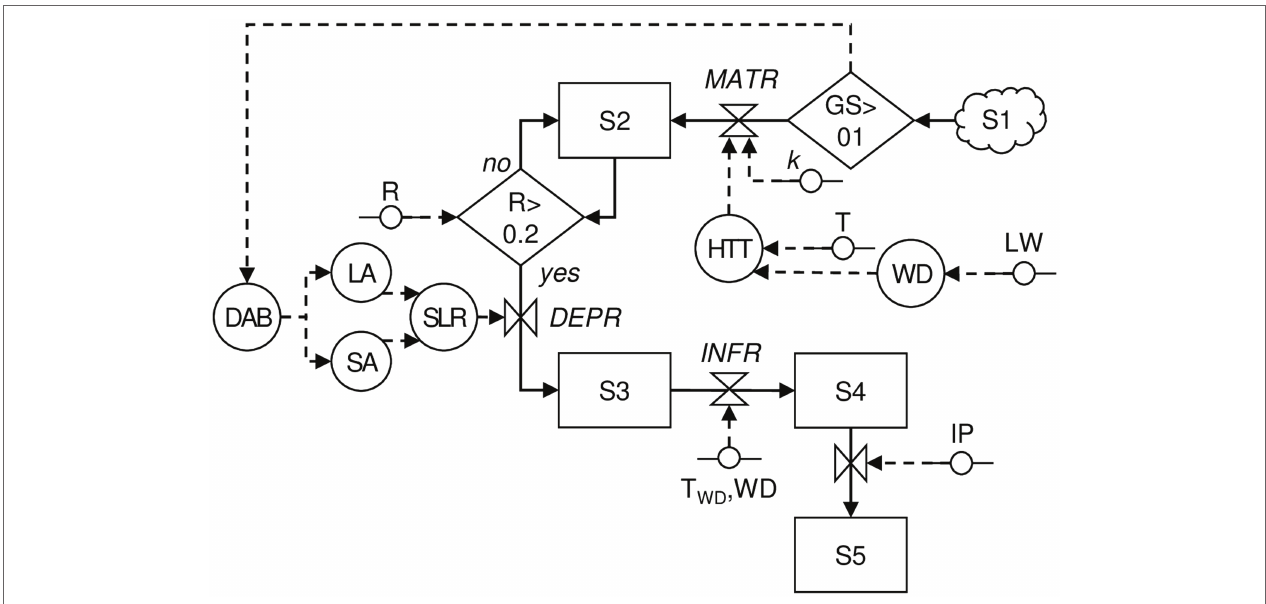
FIGURE 1 | Relational diagram of a model simulating Phomopsis cane and leaf spot (PCLS) dynamics. Boxes are state variables; line arrows show fluxes and direction of changes from one state variable to the next one; valves define rates regulating these fluxes; diamonds show switches (i.e., conditions that open or close a flux); segments with circles indicate external variables; circles indicate auxiliary variables; broken arrows link external or auxiliary variables to diamonds or circles that they influence; and clouds indicate state variables that enter or exit the system (and are not quantified). All variables are listed in Table 1